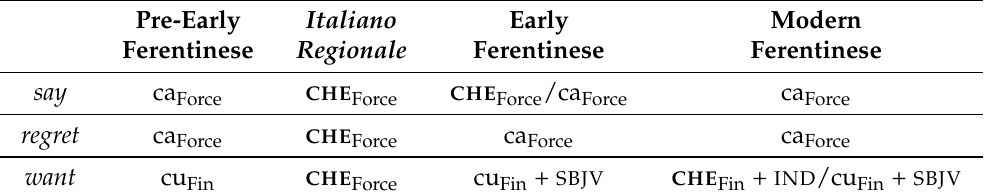
Table 3. Complementizer forms in IR, Pre-Early, Early, and Modern